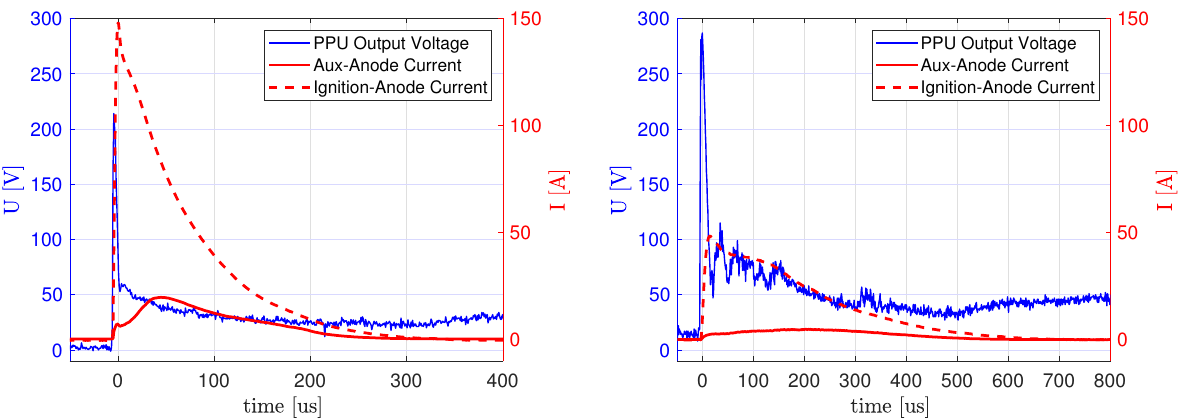
Figure 6. Current and voltage traces for C 1 = 198.2µF without ( left ) and with magnetic nozzle ( right